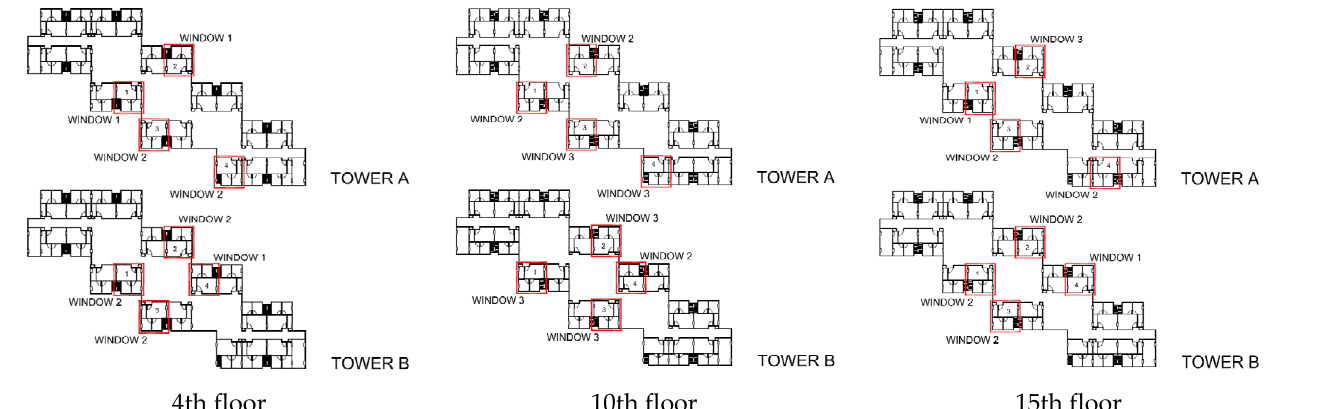
Figure 11. The horizontal mapping of the window dimensions. The simulation results indicate that the window dimensions could be determined horizontally based on the unit position within the building layout, wind direction, air ve- locity, and the elevation of the residential unit. Data interpolation was carried out in the